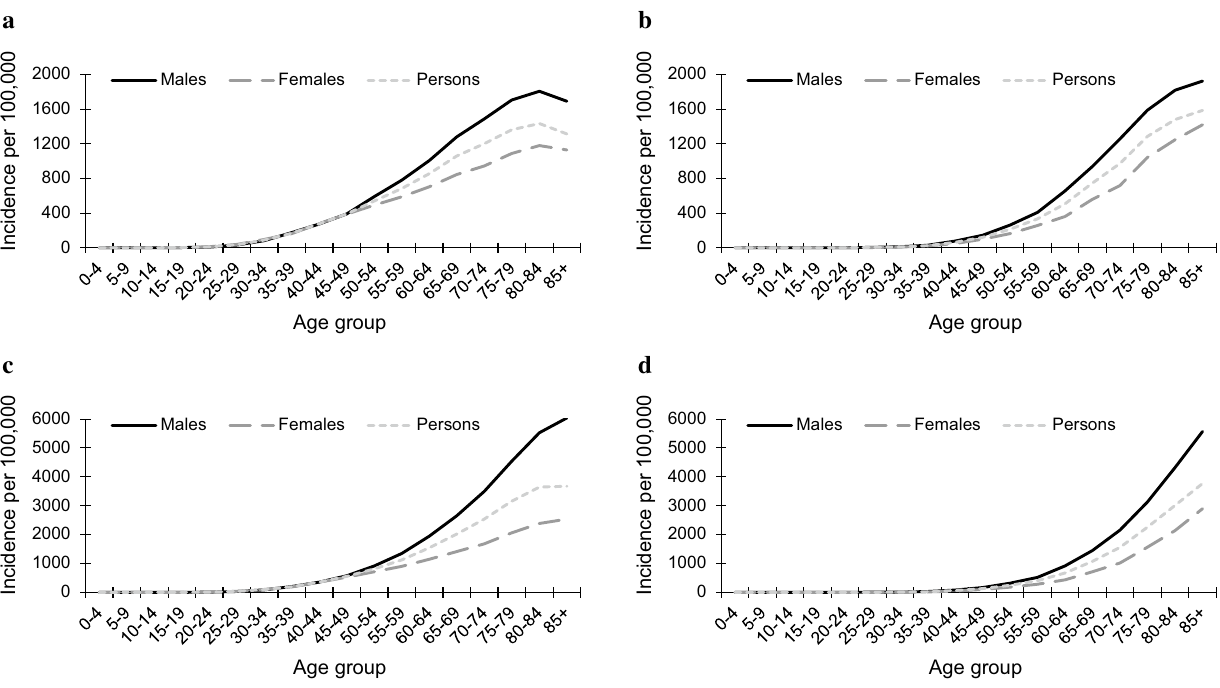
Fig. 2 Age-specific incidence rates of keratinocyte carcinoma in Tasmania, by histological type and sex. a First basal cell carcinoma, 1985– 2018; b first squamous cell carcinoma, 1985–2018; c annual basal cell carcinoma, 1978–2018; d annual squamous cell carcinoma, 1978–2018